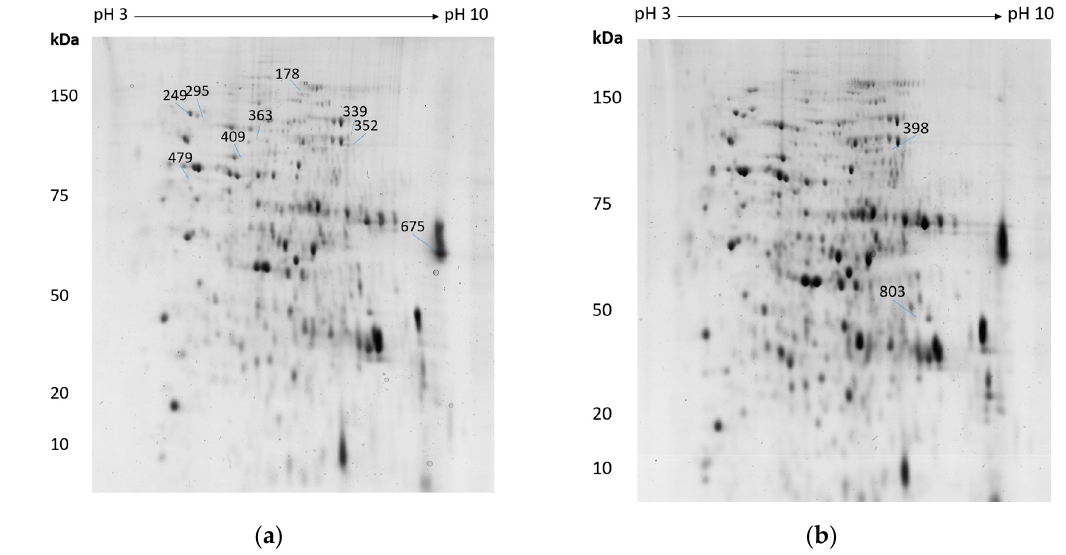
Figure 1. Reference gel images of 2-DE separation of A. mellea mycelial protein extracts following ( a ) H 2 O 2 or ( b ) menadione/FeCl 3 -induced oxidative stress for 3 h. The image shows protein spot numbers from which a single differentially-regulated protein was identified. Table 1. Details of unambiguously-identified A. mellea mycelial proteins found to be differentially abundant following H 2 O 2 or menadione/FeCl 3 -induced oxidative stress for 3 h. Proteins from 2-DE identified by SameSpots™ software, analysed by LC-MS/MS with subsequent interrogation of the A. mellea cDNA database. H 2 O 2